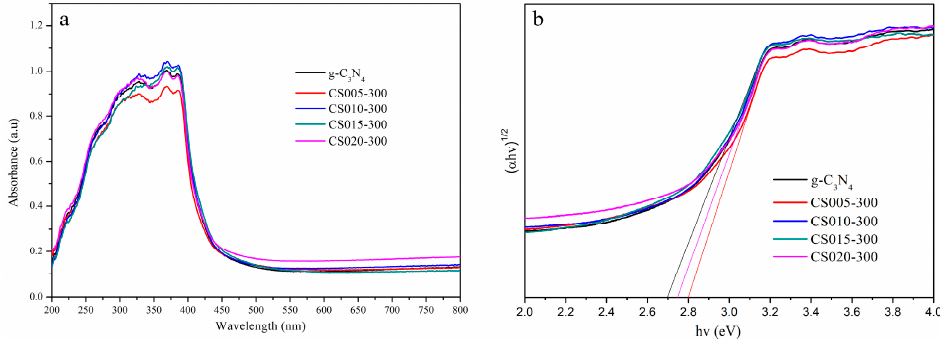
Figure 7. UV–Vis spectra ( a ) and band gap ( b ) of g-C 3 N 4 , CS005-300, CS010-300, CS015-300, CS020-300.